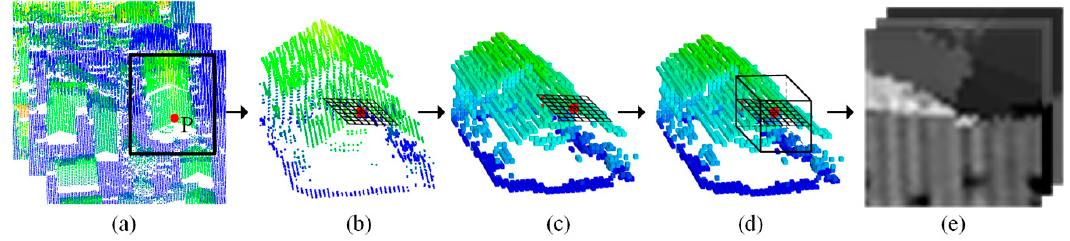
Figure 2. Projection of a feature map: ( a ) ALS point cloud display by the normalized height, intensity and change of curvature, ( b ) two-dimensional grid generation of point P, ( c ) Z value of each grid node is calculated in the voxelized point cloud, ( d ) calculating the normalized height, intensity and change of curvature of each grid node in the cube neighborhood, ( e ) feature map of point P that indicating the normalized height, intensity and change of curvature.